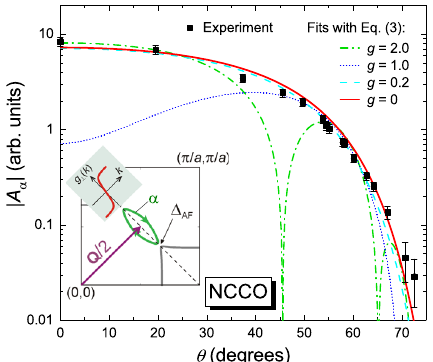
Fig. 5 Angular dependence of the SdH amplitude in optimally doped NCCO. The lines are fi ts using Eq. (3) with different g -factor values. Inset: The fi rst quadrant of the BZ with the Fermi surface reconstructed by a superlattice potential with wave vector Q = ( π / a , π / a ). If this potential involves Néel order, the function g ⊥ ( k ) (red line in the inset) vanishes at the reduced BZ boundary (dashed line). The SdH oscillations are associated with the oval hole pocket α centered at ( π /2 a , π /2 a ) 22 . The error bars are de fi ned as described in Supplementary Note